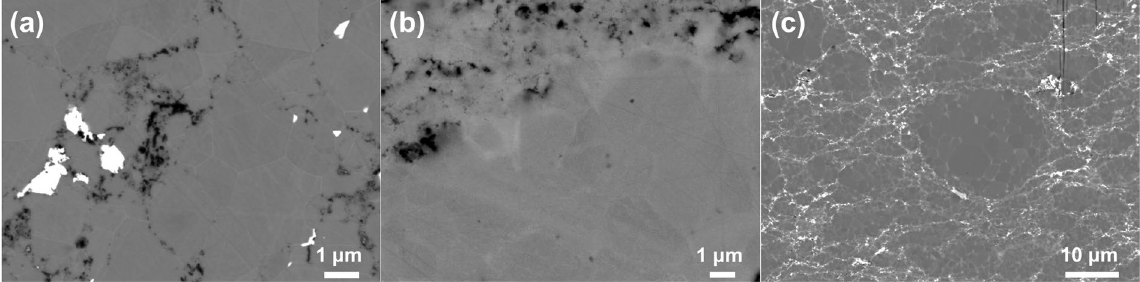
Figure 5. SEM/BSE micrographs of Mg 2 Ge 0.98 X 0.02 samples: ( a ) X = Bi, ( b ) X = Sb, and ( c ) X = Bi and ion- milled.